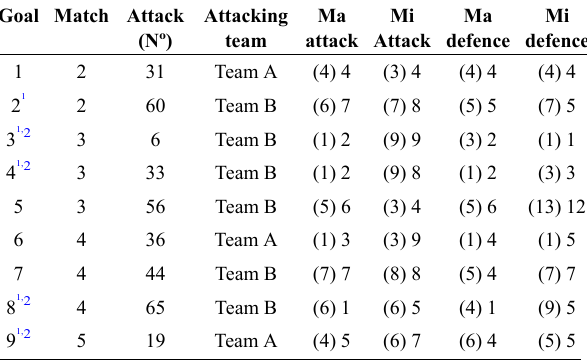
Table 3 - Attack and defence patterns in attacks when a goal was scored (Ma = macrostructure; Mi = microstructure). Goal Match Attack (N º